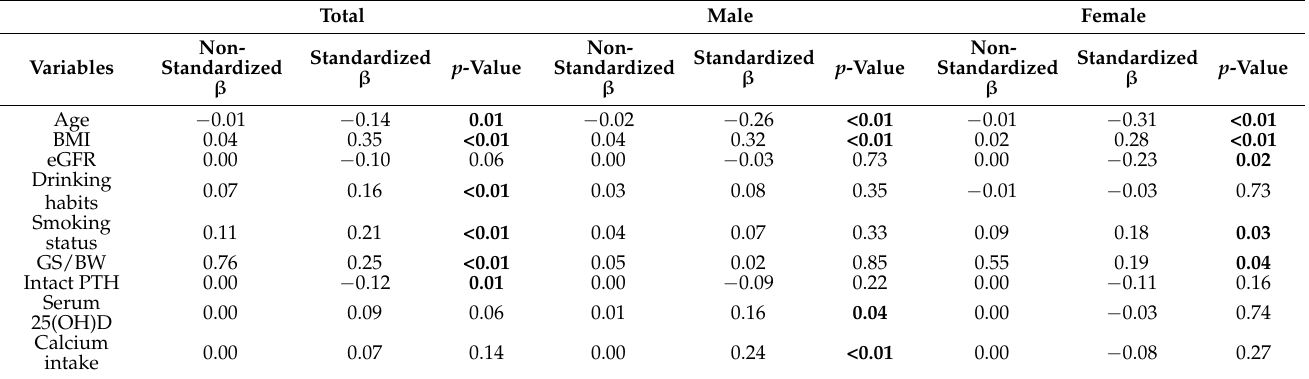
Table 5. Multiple regression analysis of the OSI as a dependent variable according to